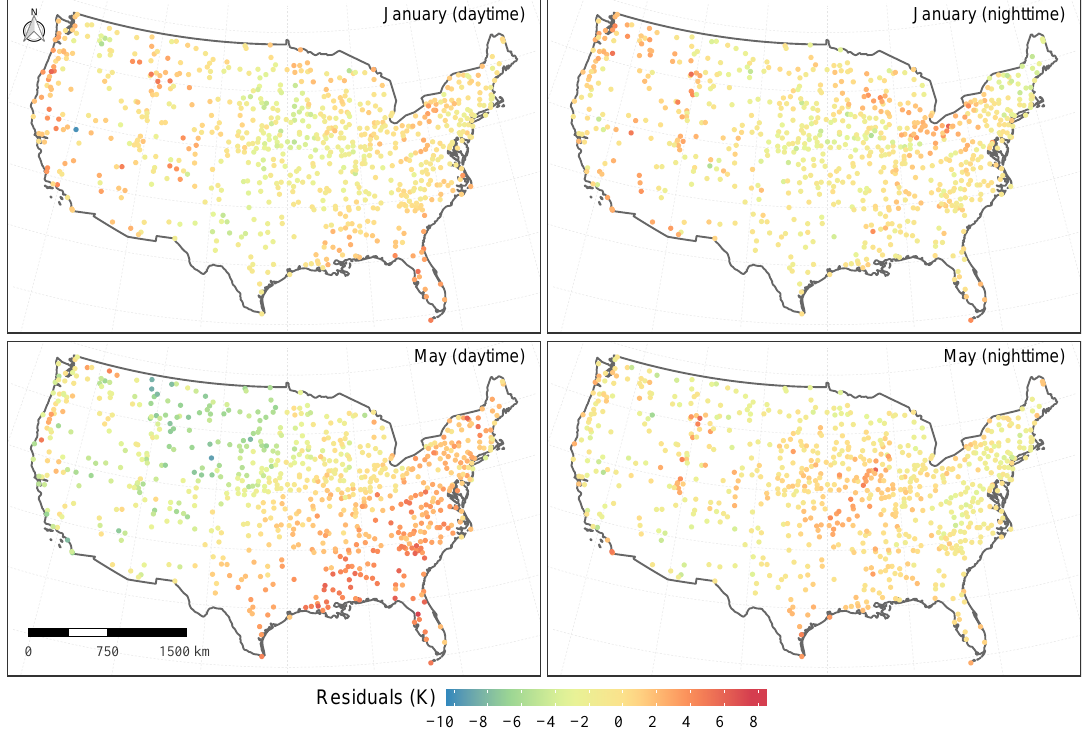
Figure 4. Spatial distributions of residuals in the linear regression (LR) models ( top left : the LR model in the daytime case in